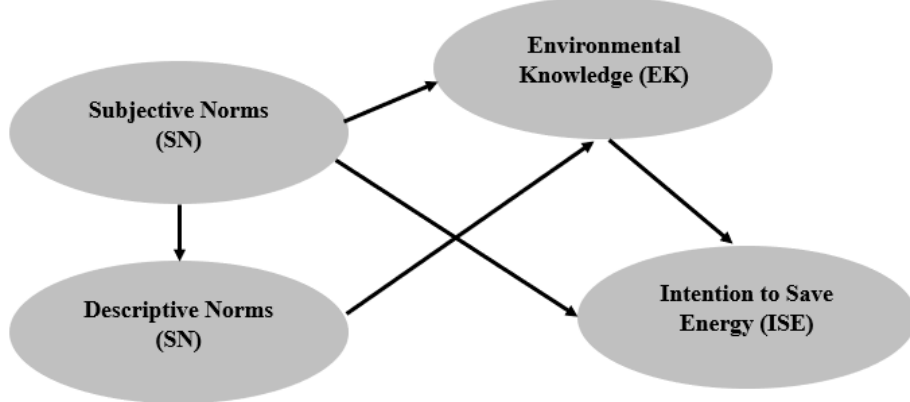
Figure 2. Research model.